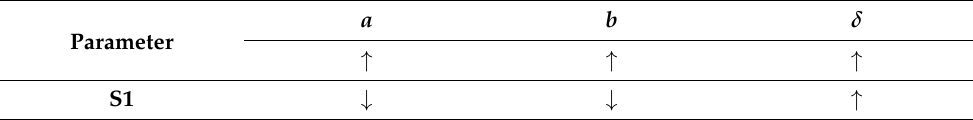
Table 12. Correlation analysis of the parameters in the first system. Parameter